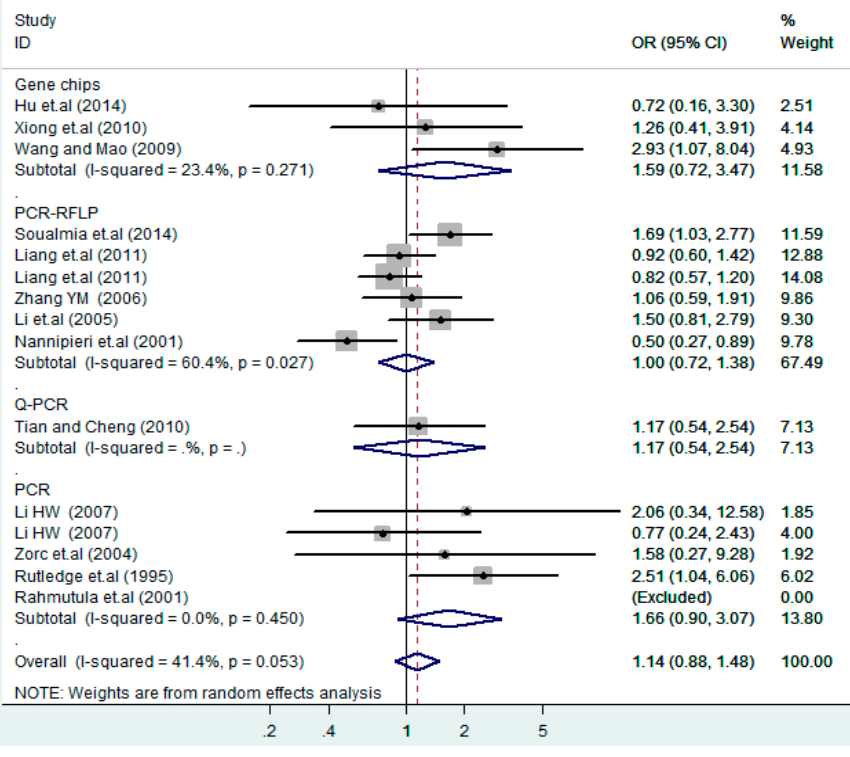
Figure 20. Subgroups of genotyping methods of T2238C co-dominant model-1 (TC vs. TT).